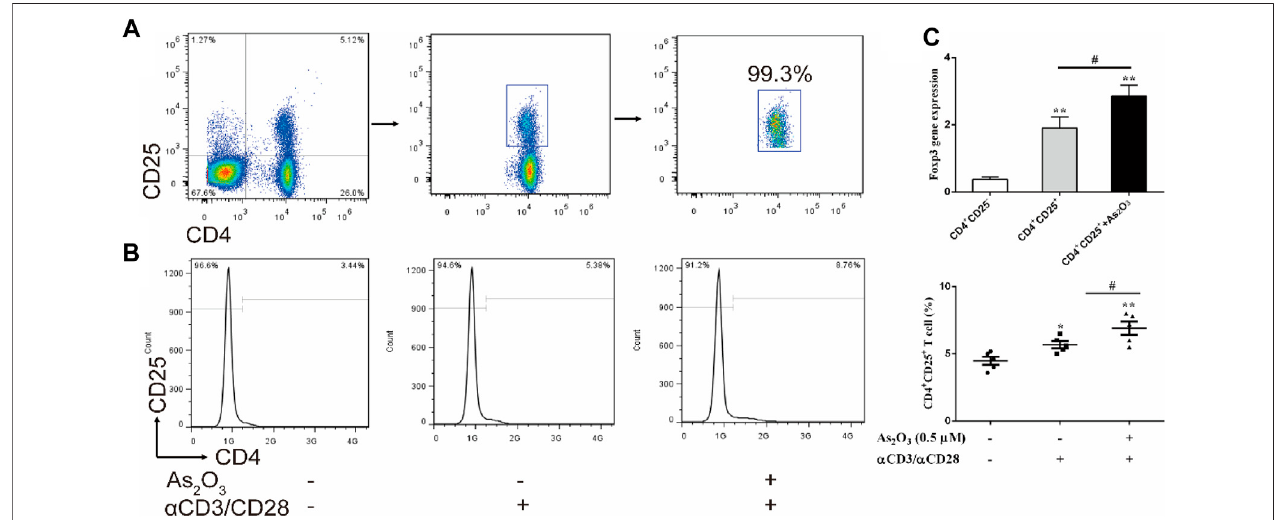
FIGURE 4 | As 2 O 3 increased CD4 + CD25 + Treg-cell proportion by regulating Foxp3 expression. (A) CD4 + CD25 + Treg cells and CD4 + CD25 − T cells were isolated from PBMCs in treatment-naïve RA patients. The purity of obtained cells was ≥ 99% con fi rmed by fl ow cytometry. (B) Histograms represent the proportion of CD4 + CD25 + Treg cells from treatment-naïve RA patients in absence or presence of As 2 O 3 (0.5 μ M) and with or without anti-CD3/CD28 activation in vitro . (C) qRT-PCR for detection of Foxp3 from puri fi ed CD4 + CD25 + Treg-cell subsets. The statistical analysis was performed using one-way ANOVA. Data are represented as the mean ± SEMinsixindependentexperiments. # p < 0.05, ## p < 0.01 vs nontreatmentcells;* p < 0.05,** p < 0.01vs.CD4 + CD25 − Tcellsfromtreatment-naïveRApatients.